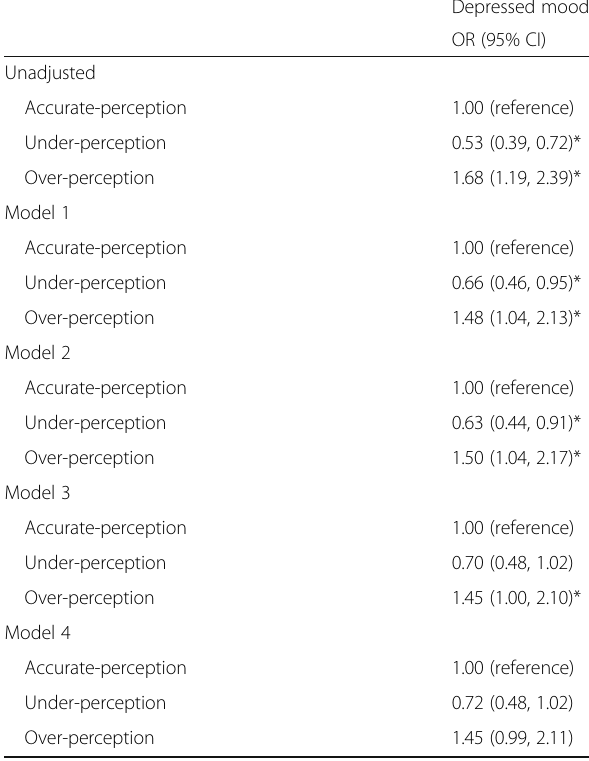
Model 1: Adjusted for age and gender Model 2: Adjusted for covariates in Model 1, household income, education level, employment status, marital status, and area of residence Model 3: Adjusted for covariates in Model 2, self-rated health, smoking, and high risk drinking Model 4: Adjusted for covariates in Model 3 and meeting any type of recommended level of physical activity * p